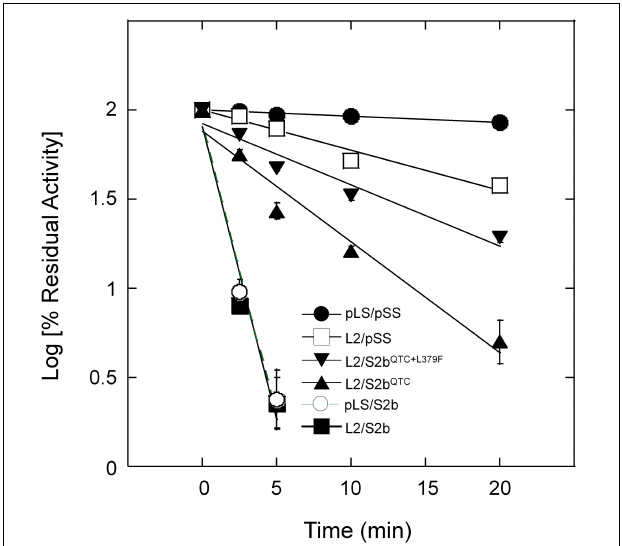
FIGURE 4 | Thermal stability of AGPases. Samples were heat-treated at 55 ◦ C for various durations (0 ∼ 20 min) and then immediately placed on ice. Enzyme activity was determined after diluting the protein samples with 50 mM HEPES-NaOH (pH 7) and 5 mM DTT. Enzyme assay was performed under standard condition (see section “Materials and Methods”). Residual activity (%) was calculated with respect to the activity of the control samples not treated with heat. The data points are mean values ( ± SE) based on the results from three replicate assays. Linear fitting of time versus log (% residual activity) was done with Kaleidagraph 4.5.4 (Synergy Software). No error bars are shown for certain points because they are smaller than the sizes of the